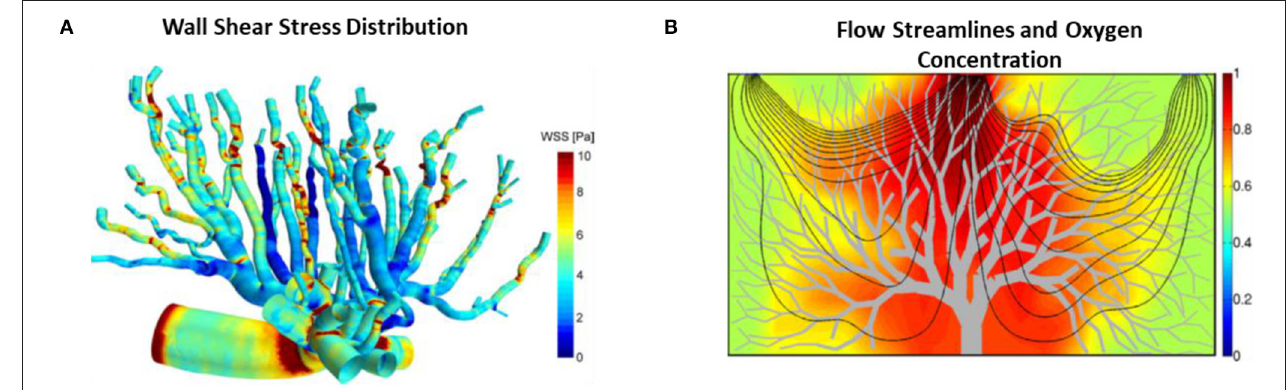
FIGURE 4 | Placental blood flow modeling. (A) WSS color contours on mouse placenta vasculature performed using CFD (Bappoo et al., 2017). (B) Blood flow streamlines and oxygen concentration field in the 2D placenta model (Lin et al.,